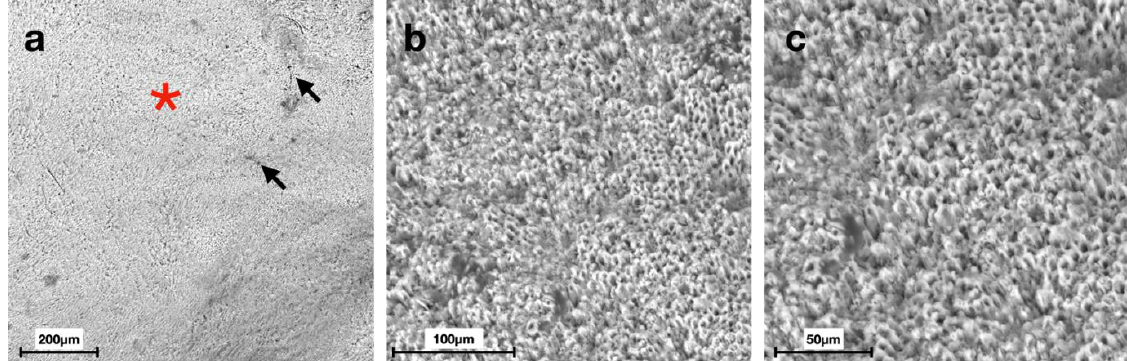
Figure 6. Scanning electron micrographs of G3 (Duraphat Group): ( a ) an irregular surface (red asterisk) with residues of the material evident on the surface (black arrows) at 200× magnification; ( b , c ) the presence of the enamel prisms with partially intact crystals and an almost restored structure of the interprismatic area at 500× and 1000× magnification, respectively.